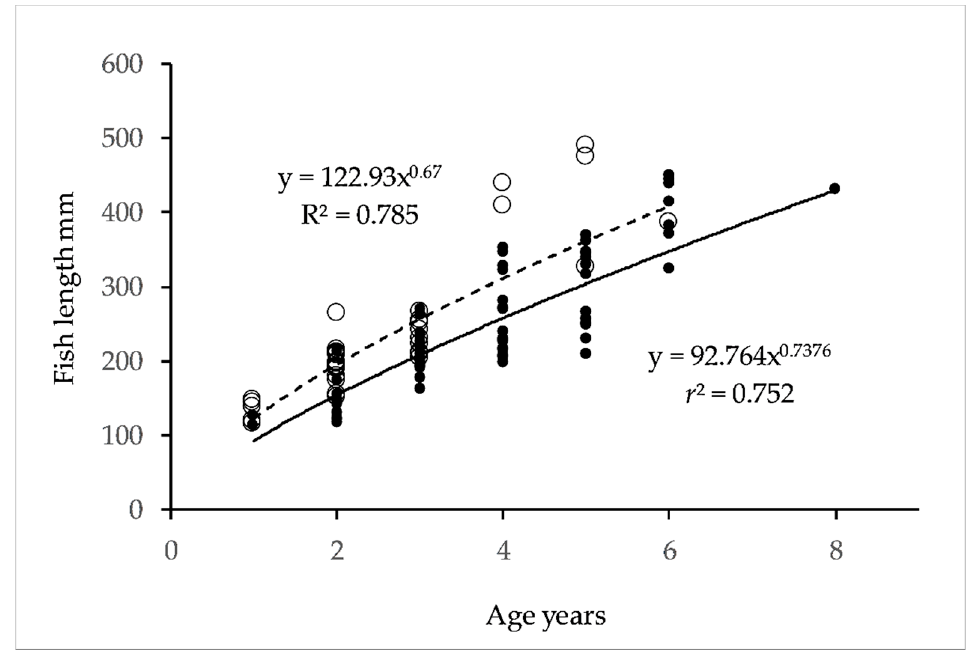
Figure 2. Body length of recaptured stocked (open circles, dotted line) and wild (filled circles, solid line) brown trout caught in Lake Savalen 2010, plotted on age (modified after Johnsen et al. [17]).